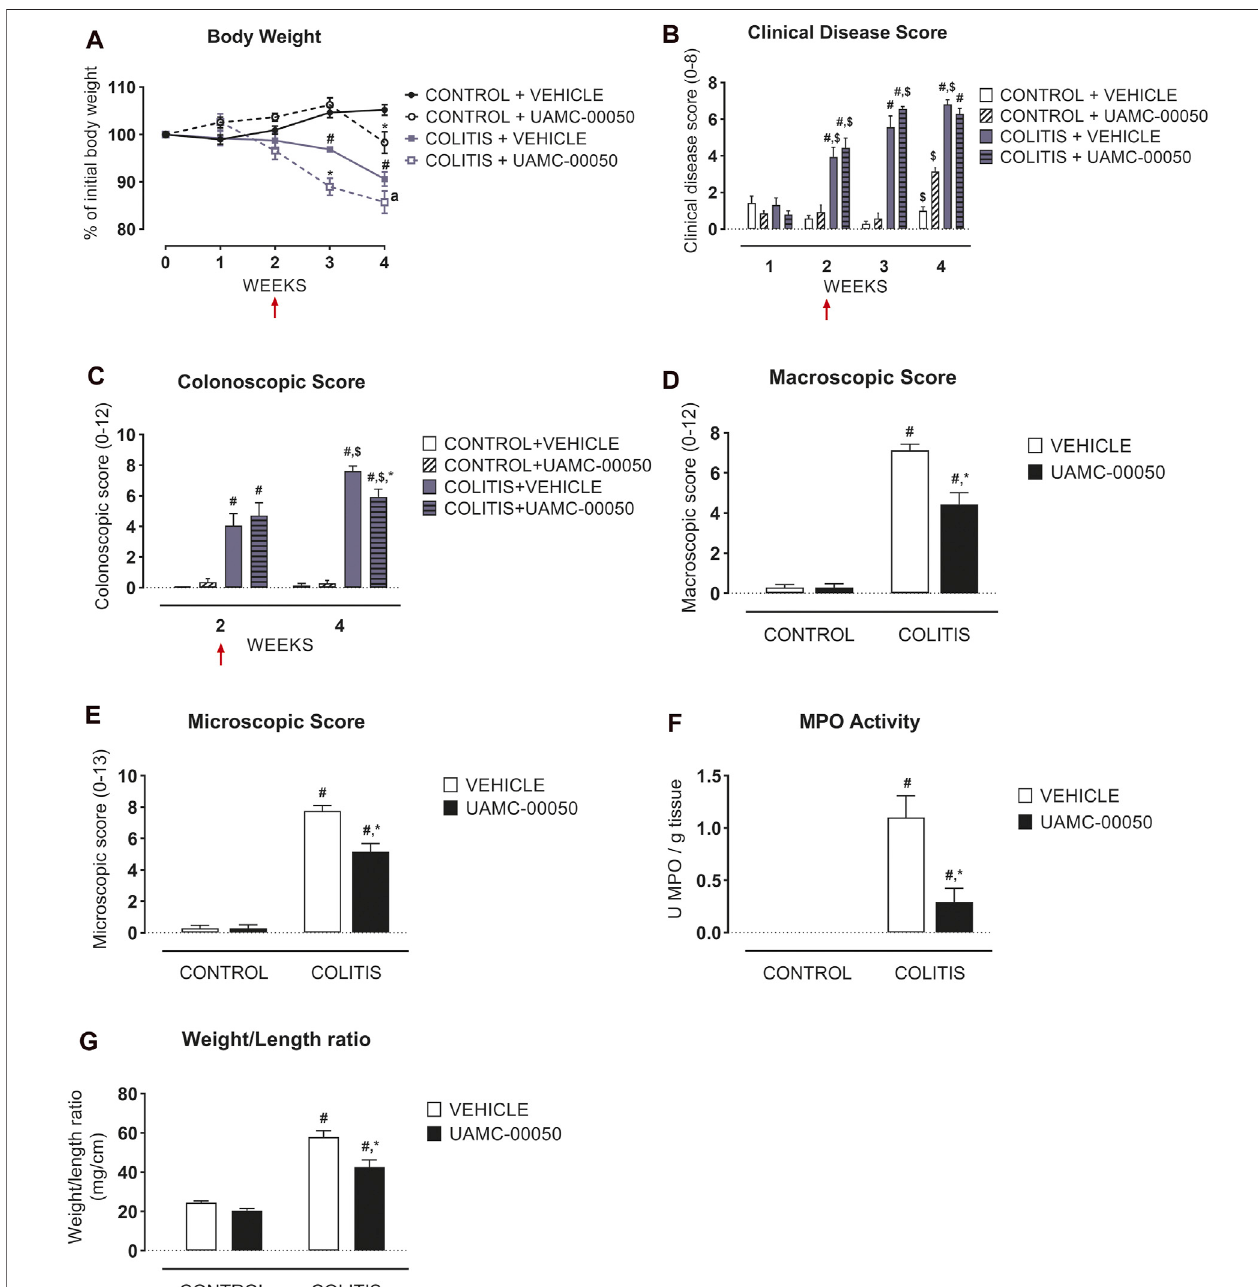
FIGURE2| Effectofcurativetreatmentwith UAMC-00050on in fl ammatory parametersin experimental colitis. Effect on body weight (A) ,clinical disease score (B) ,colonoscopicscore (C) ,macroscopicscore (D) ,microscopicscore (E) , MPOactivity (F) and colonicweight/lengthratio (G) . Theredarrowsindicatethestart of the UAMC-00050 treatment in (A – C) . The data for (D – G) are post-mortem markers determined at week 4. Data are represented as mean ± SEM. Generalized Estimating Equations (GEE) + Least signi fi cant difference (LSD) posthoc test (A – C) , Two-way ANOVA followed by One-way ANOVA and LSD post-hoc test when appropriate (D – G) . # p < 0.05; signi fi cant effect of colitis, * p < 0.05; signi fi cant effect of treatment, $ p < 0.05; signi fi cant effect of time, a p (cid:2) 0.06. n (cid:2) 7 – 8/ group.